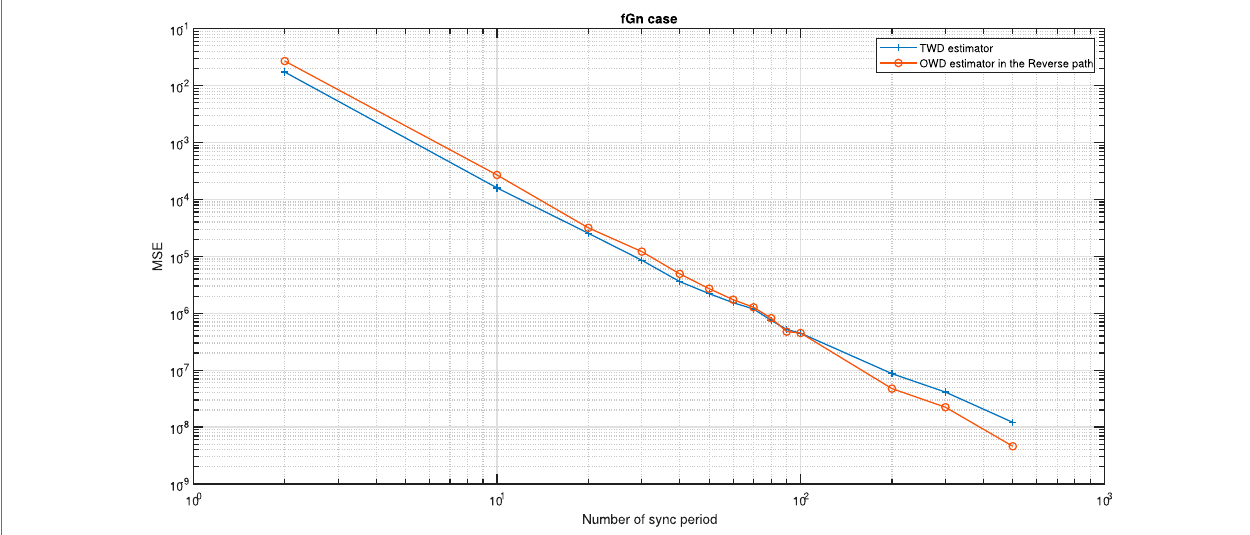
) , H = 0.6, d σ 2 (cid:2) σ 2 (cid:2) 4 e − 6 [ sec 2 ] , Z = ω 1 ω 2 ms = 2.5 ms , d sm = 3 ms , sec